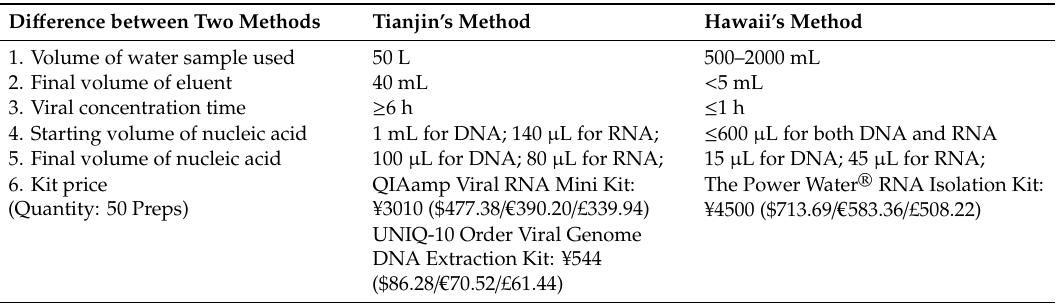
Table 10. Comparison of Tianjin’s method and Hawaii’s method for viral